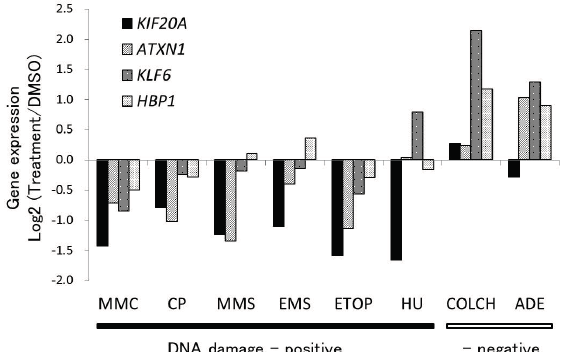
Figure 1. Expression profiles of four genes on treatment with the genotoxins used in microarray analysis. The genes ATXN1 , KIF20A , KLF6 , and HBP1 , which are a part of CDKN1A -centered network, were downregulated in response to DNA damage. The log base 2 values of the ratio of alterations in the expression of these four downregulated genes to the mean values of the corresponding control obtained from the microarray data (single experiment in duplicate) are shown. TK6 cells were treated with MMC, mitomycin C; CP, ETOP, etoposide; HU, hydroxyurea; COLCH, colchicine; and ADE, adenine; for 4 h at concentrations corresponding to 50% of relative cell growth (RCG) compared to number of cells in vehicle control, and allowed to recover for 20 h in standard cell culture